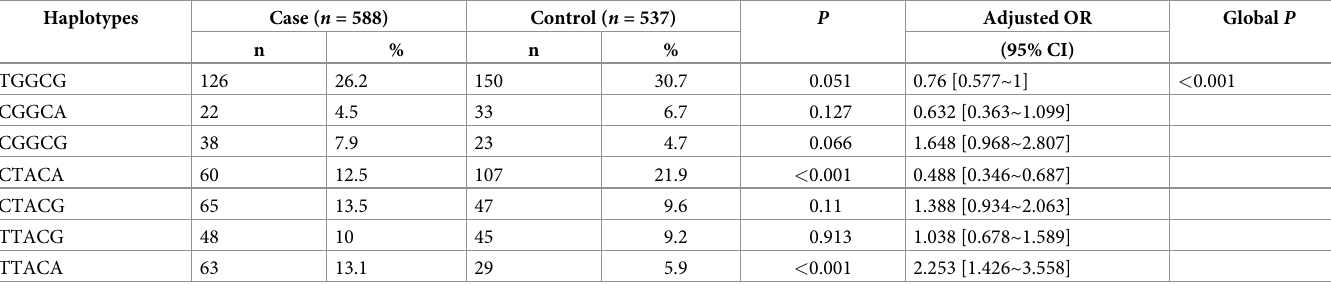
Table 4. Distribution of inferred haplotypes in the subjects and their links with risk of NIHL.